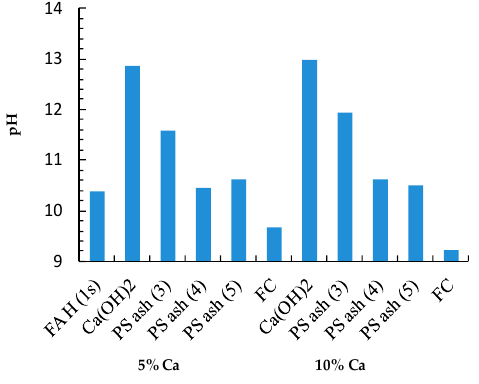
Figure 1. Leachate pH values from fly ash H alone and fly ash H under five kinds of additives for 5% and 10% Ca content samples.